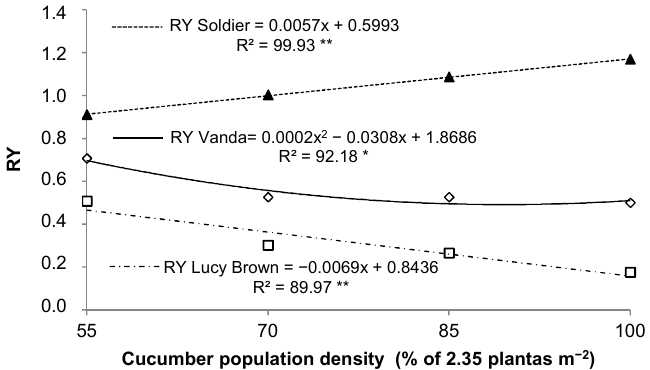
Figure 8. Relative yield (RY) of the intercropping components of ‘Vanda’ and ‘Lucy Brown’ with cucumber. ◊ RY ‘Vanda’; □ RY ‘Lucy Brown’; ▲ RY ‘Soldier’. * p ≤ 0.05; **: p ≤ 0.01 in F test.